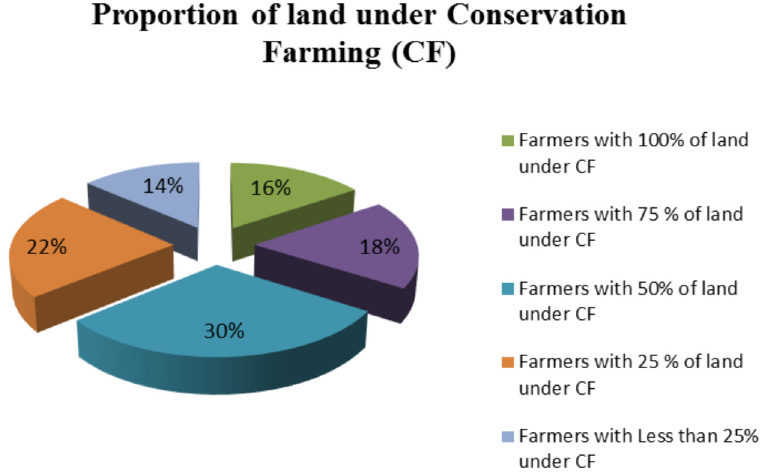
Figure 4. Proportion of land that is placed under conservation farming.